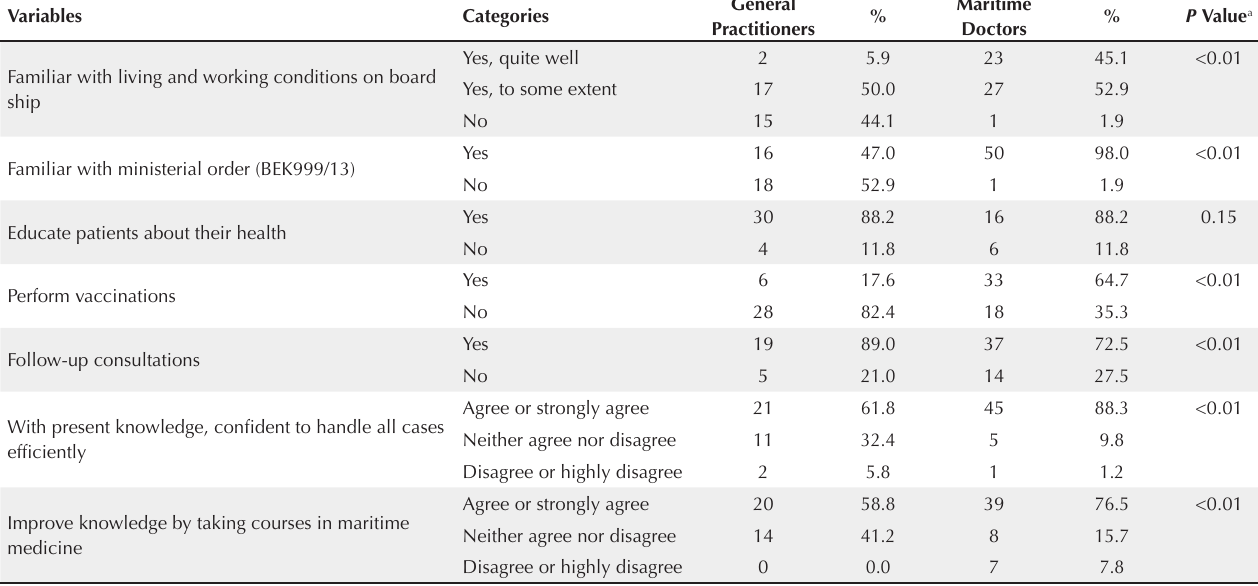
Table 2. Selected Questions About the Range of Services and Maritime Knowledge of GPs (n = 34) and Maritime Doctors (n = 51) Variables